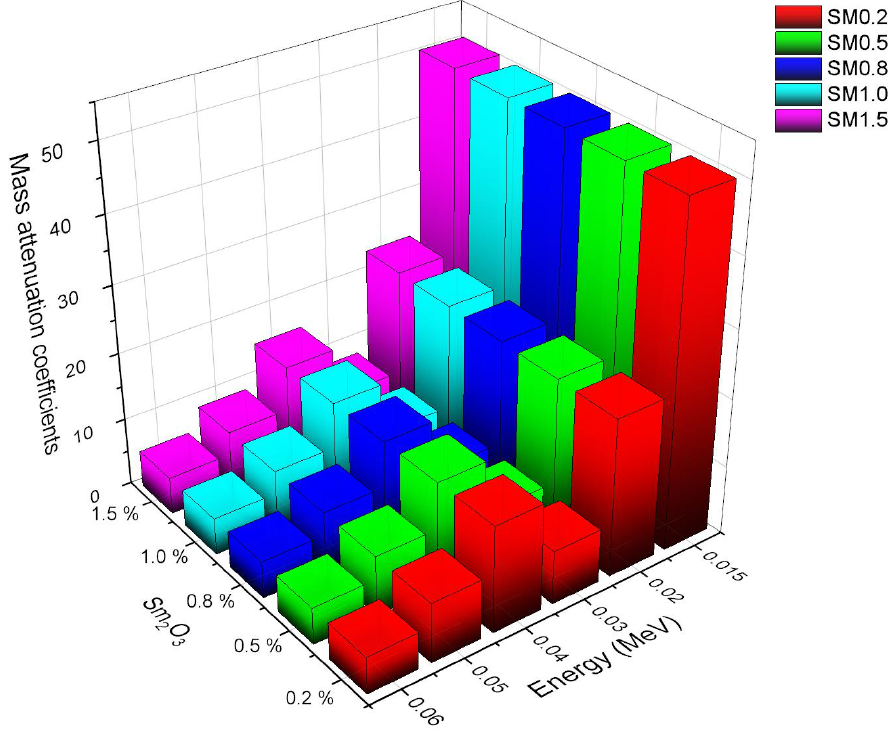
Figure 4. Variation of linear attenuation coefficient ( µ ) against Photon energy for all glasses.